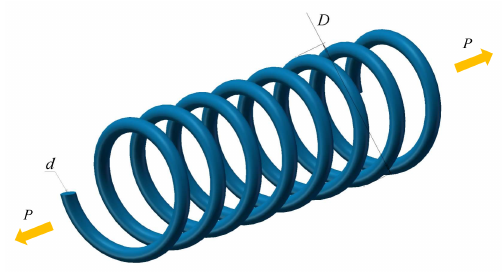
Figure 10. Tension/Compression Spring